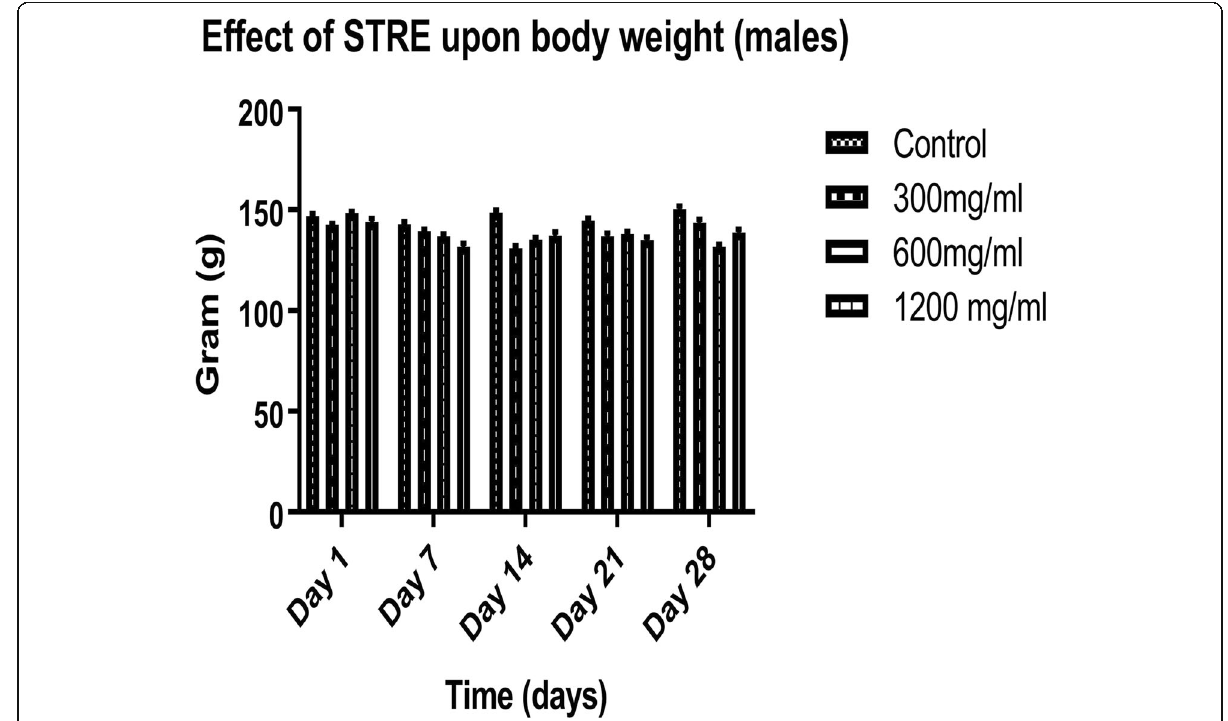
Fig. 1 Effect of STRE on bodyweight of male subjects. Values are expressed as mean ± SEM Statistical significance (p) calculated by one way ANOVA followed by dunnett ’ s ( n =